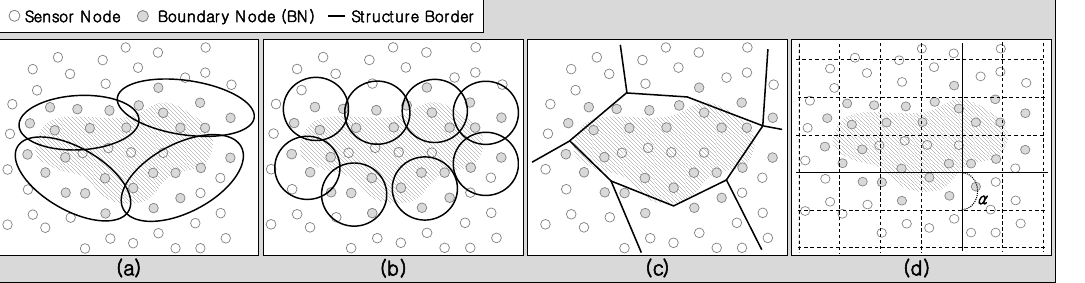
Figure 3. Integration strategies: ( a ) reactive cluster, ( b ) reactive one-hop cluster, ( c ) proactive cluster, and ( d ) hybrid